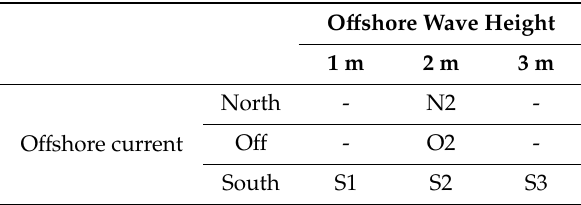
Table A1. Summary of simulations.